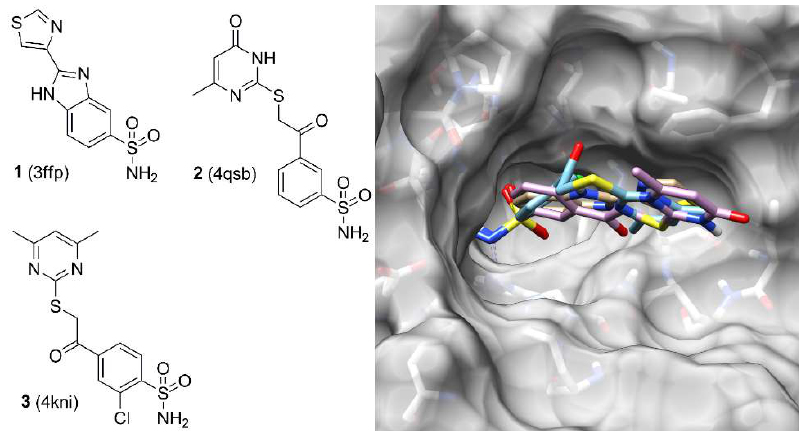
Figure 5. 2D structure of compounds 1 , 2, and 3 and their superimposable disposition into the CAII binding site.